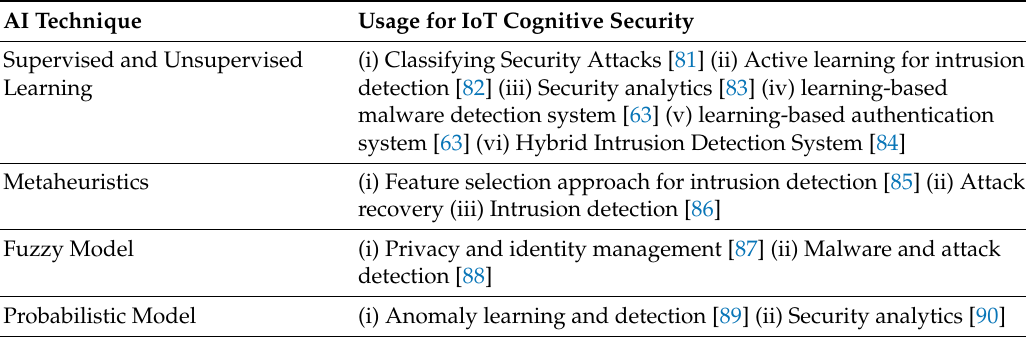
Table 4. Summary of the usage of AI in IoT cognitive